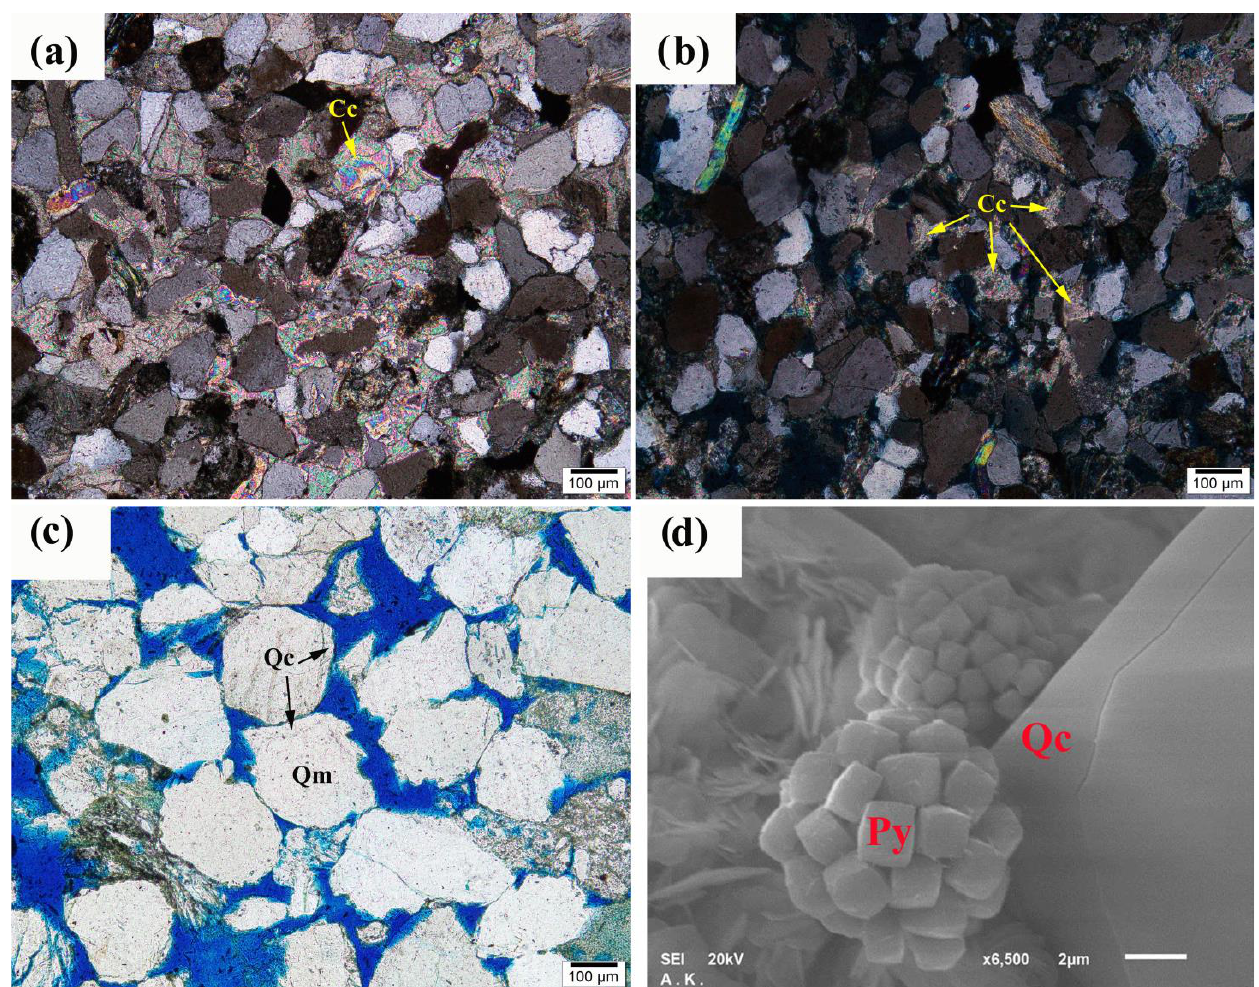
Figure 11. Photomicrograph showing ( a ) poikilotopic calcite cement (Cc) at 3179.5 m depth; ( b ) isolated pore-filling calcite cement (Cc) at 3085.5 m depth; ( c ) quartz overgrowth at 3182 m depth; ( d ) SEM shows framboidal aggregates of pyrite (Py) and quartz overgrowth (Qc) [4]. Quartz Cement